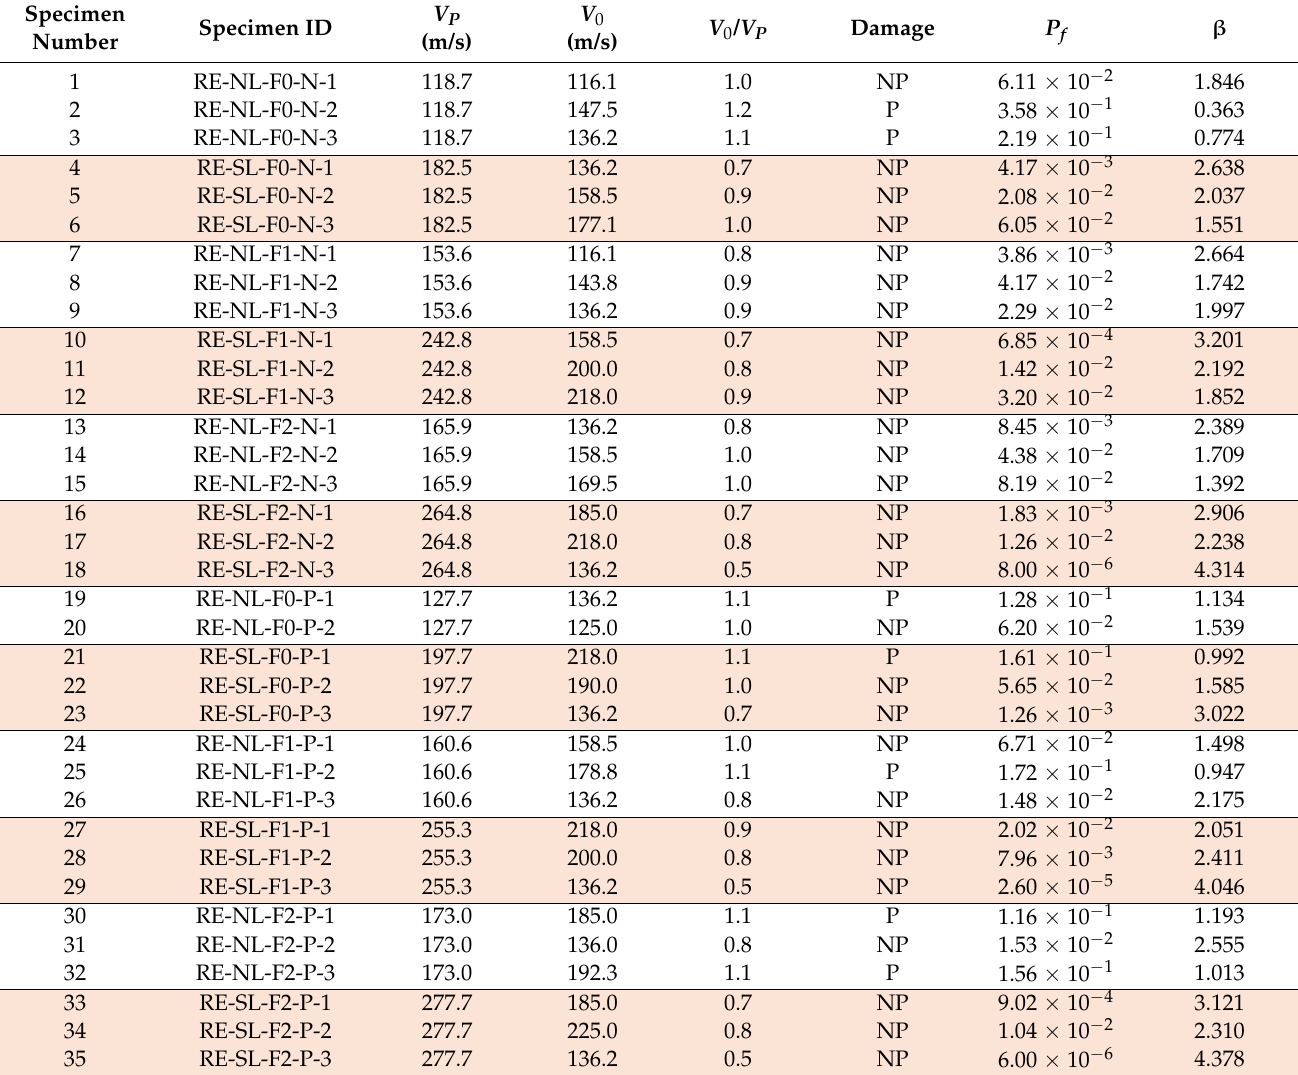
Table 3. Output of the MCS-based reliability